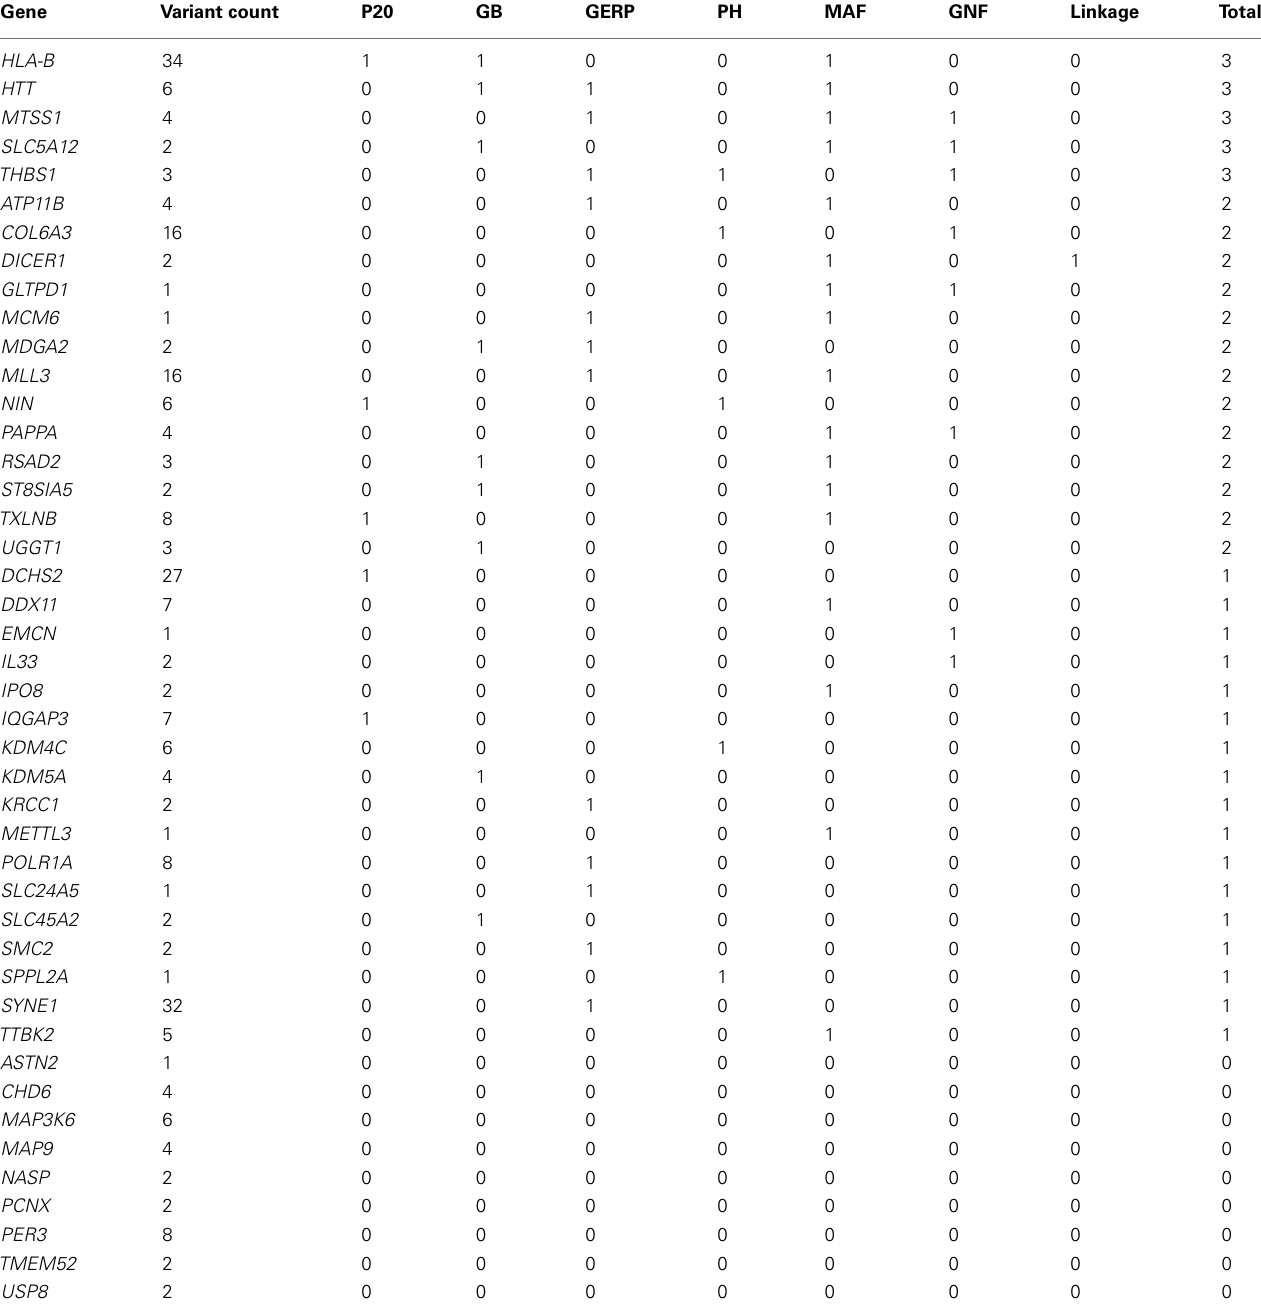
Table 5 | Candidate gene ( N = 44) prioritization given a composite score of seven supportive functional and/or statistical categories.